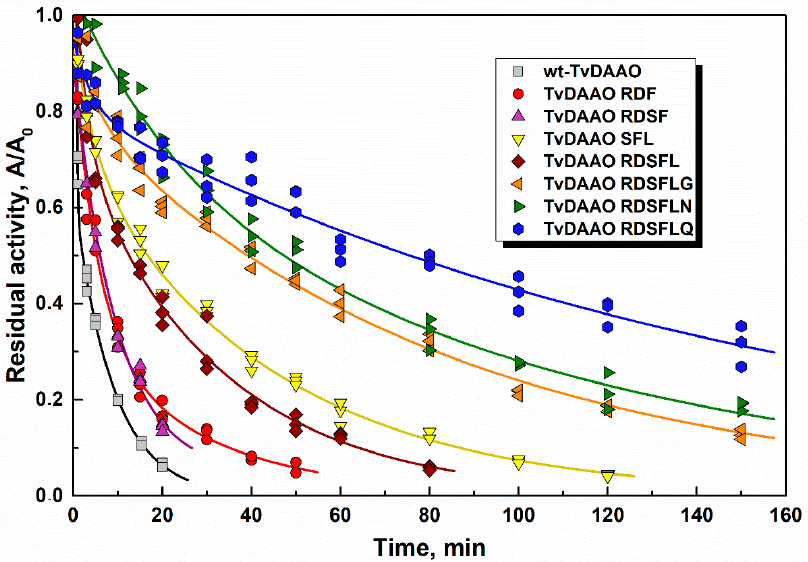
Figure 2. Inactivation time-course for the wild-type TvDAAO and mutant enzymes at 60 °C (0.1 M potassium phosphate buffer pH 8.0). Enzyme concentration is 10 µg/mL.